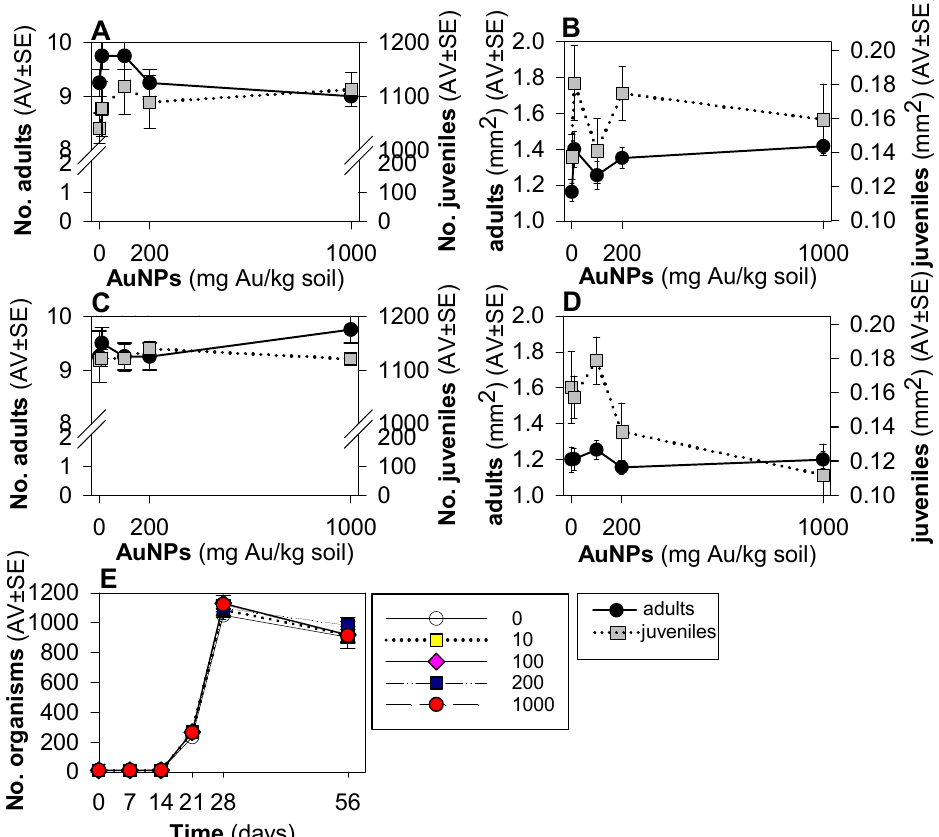
Figure 2. Results of the reproduction test with Folsomia candida when exposed in LUFA 2.2 soil to gold nanoparticles (AuNPs), in terms of number of adults, juveniles and size at day 28 ( A , B ), at day 56 ( C , D ), and in terms of total number of organisms at days 0, 7, 14, 21, 28 and 56 of exposure ( E ). Values are expressed as average ± standard error (AV ± SE).